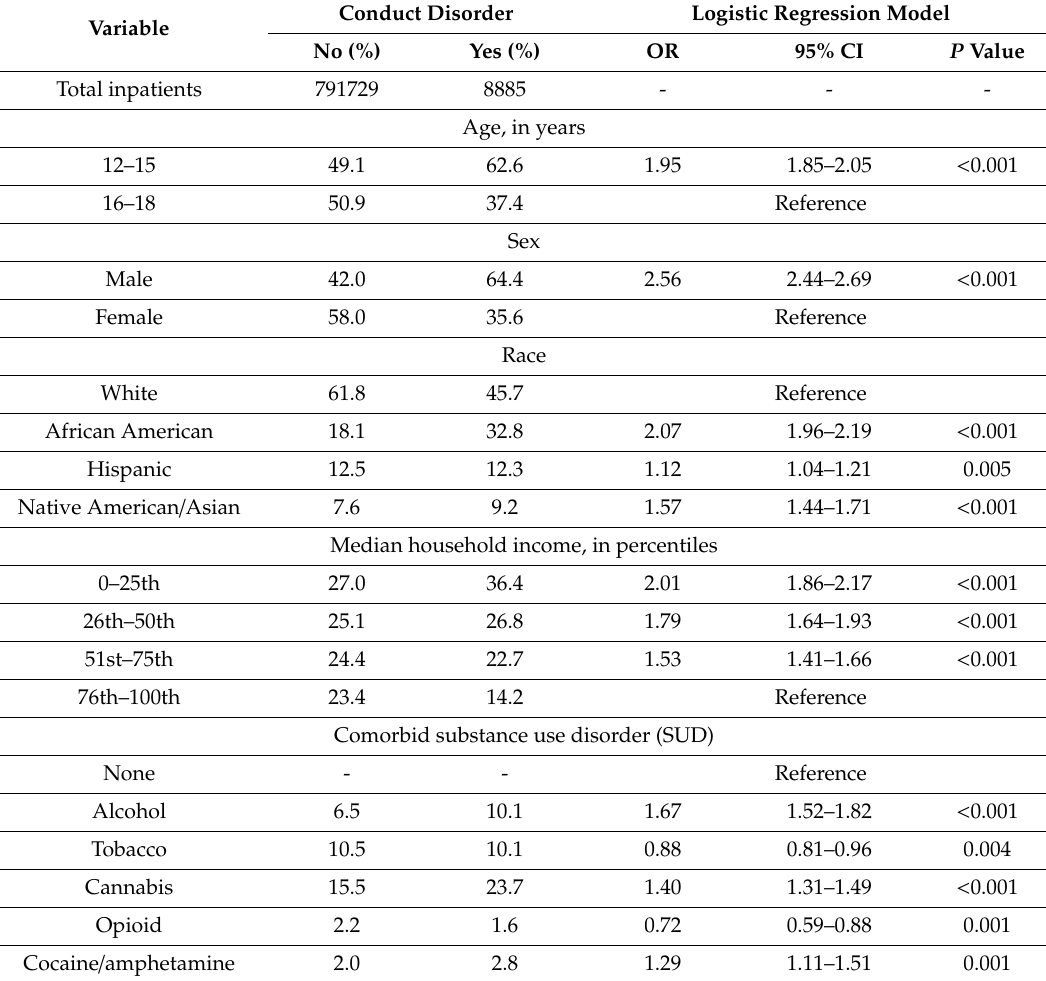
Table 1. Di ff erences in conduct disorder (CD) and non-conduct disorder